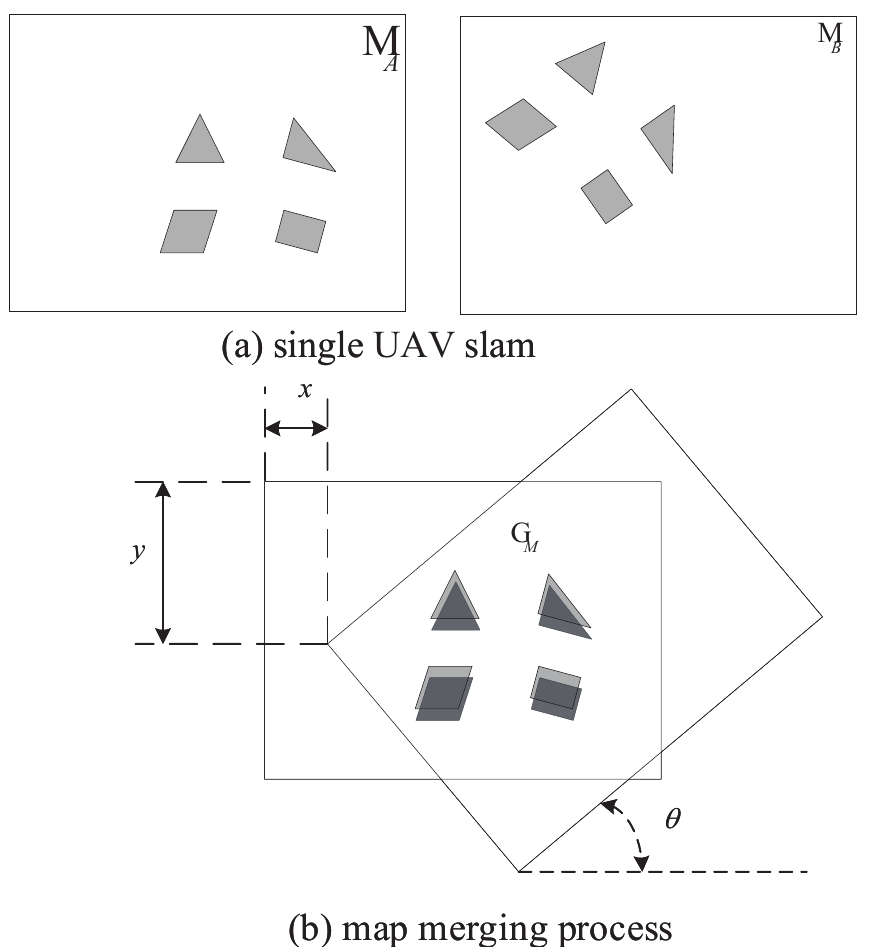
Figure 3. Map-stitching